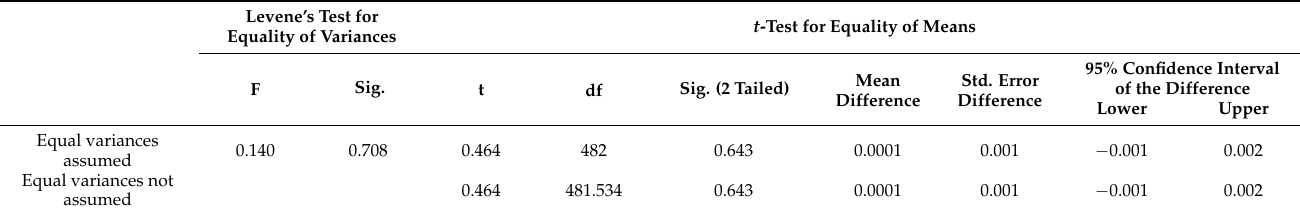
Figure A2. Relationship between measured and simulated dew intensity in 2020 and 2021. Table A3. Independent-Samples